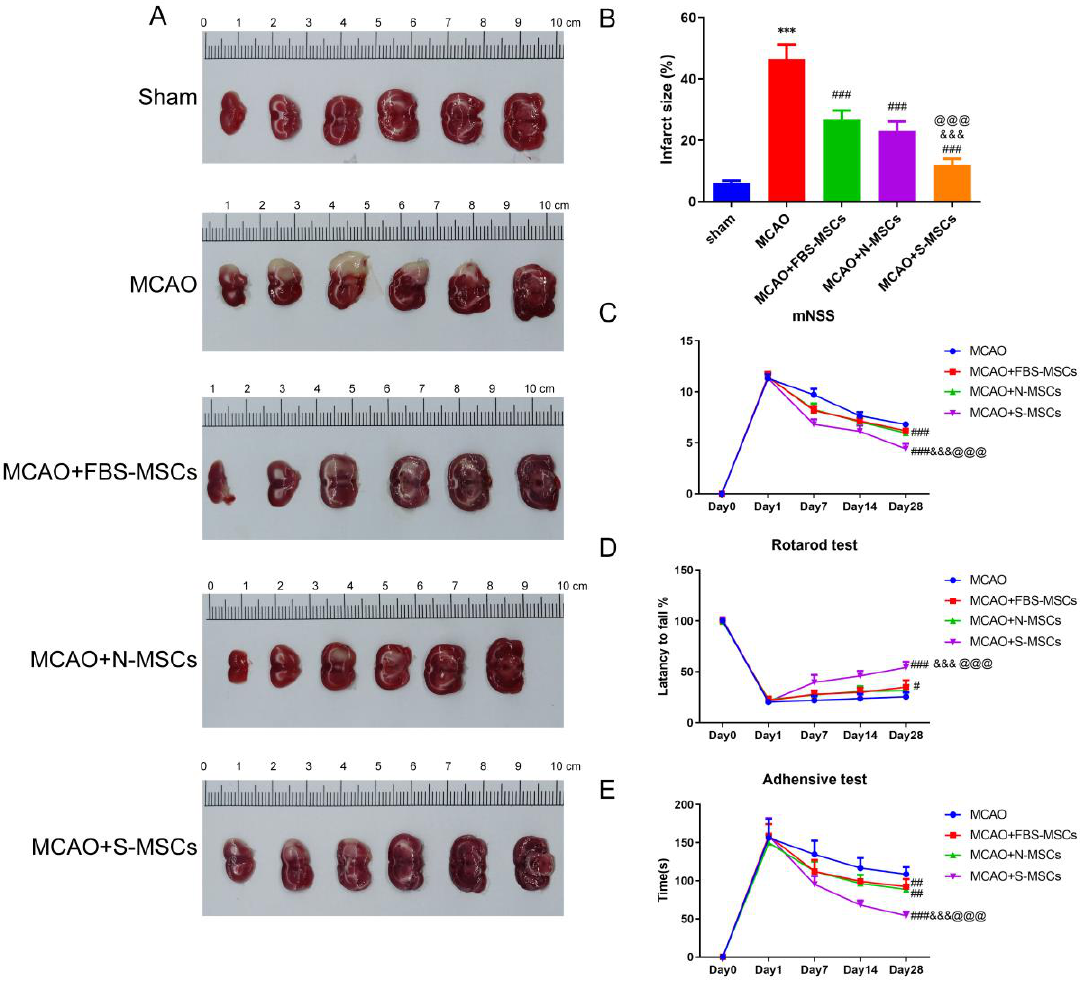
Figure 5. S-MSCs reduced the cerebral infarction volume and alleviated neurologic deficits in ischemia/reperfusion (I/R) rats: ( A ) Cerebral infarct area in MCAO rats (TTC staining). ( B ) Quantita- tive analysis of the cerebral infarct volume. Results of behavioral tests. ( C ) mNSS scores. ( D ) The rotarod test. ( E ) The adhesive-removal test. Compared with the sham group, *** p < 0.001; compared with the MCAO group, # p < 0.05, ## p < 0.01 and ### p < 0.001; compared with the MCAO + FBS-MSCs group, &&& p < 0.01; compared with MCAO + N-MSCs group, @@@ p < 0.001. ( x ± s, n =